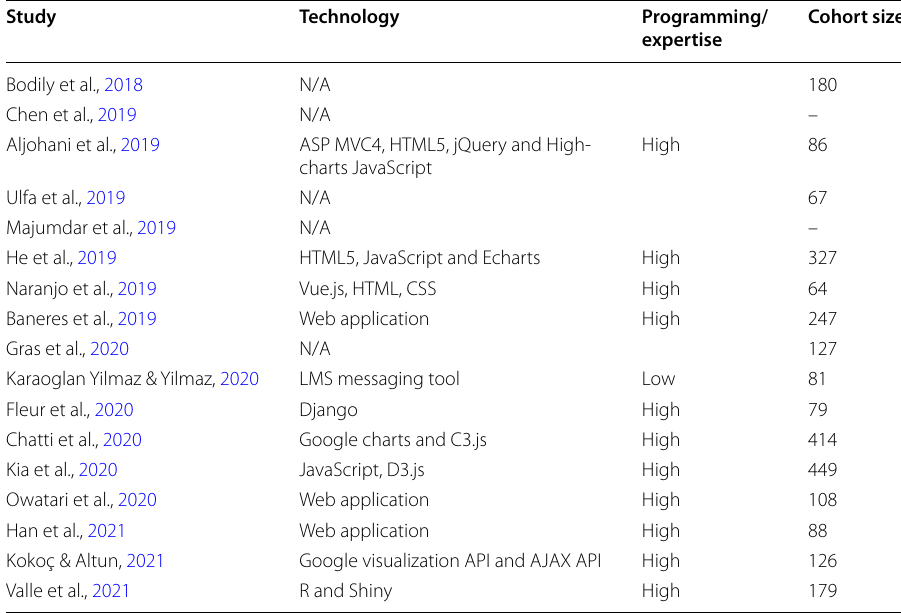
Table 2 Dashboard technologies and size of study cohorts